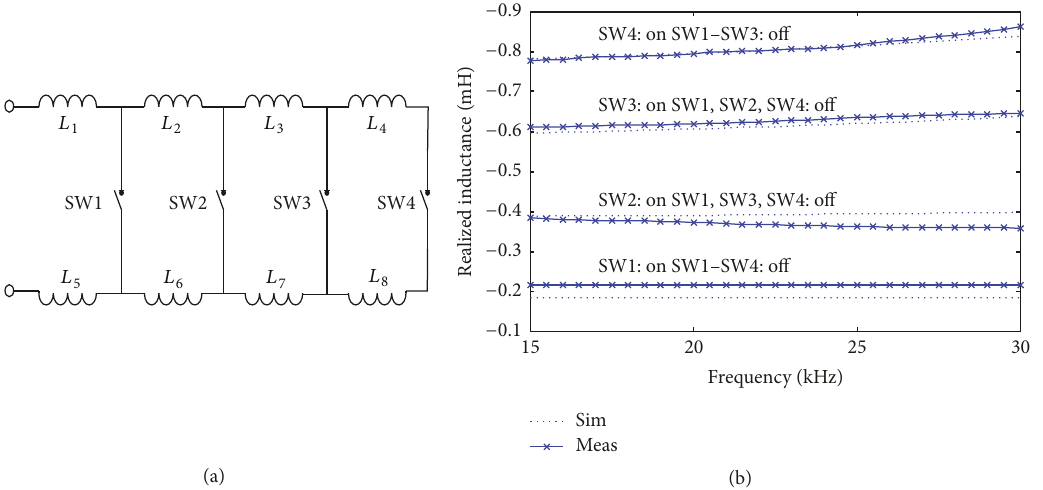
Figure 4: (a) Series-connected tunable inductor fabricated in the NFC; (b) the simulated and measured inductance of the tunable inductor.